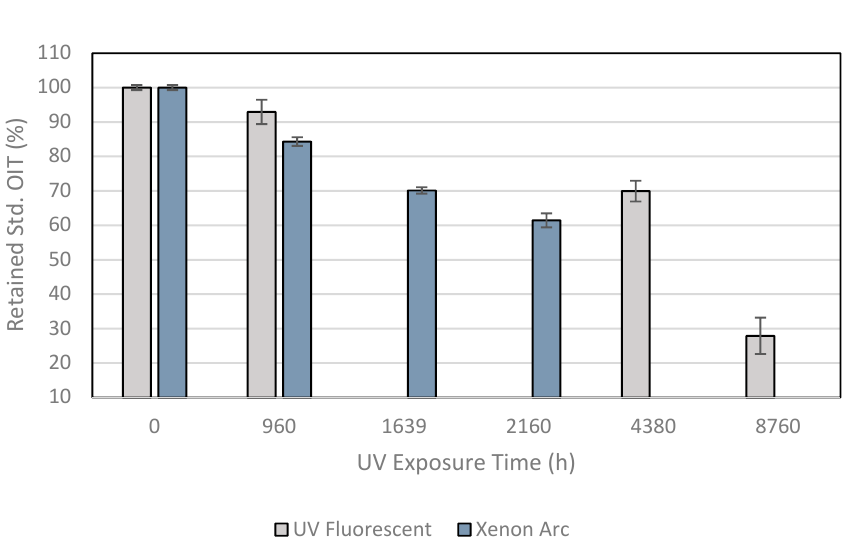
Figure 3. Std. OIT test results showing behavior of the samples after UV exposures. Reis et al. [14] evaluated the Std. OIT results for two weathering exposure locations